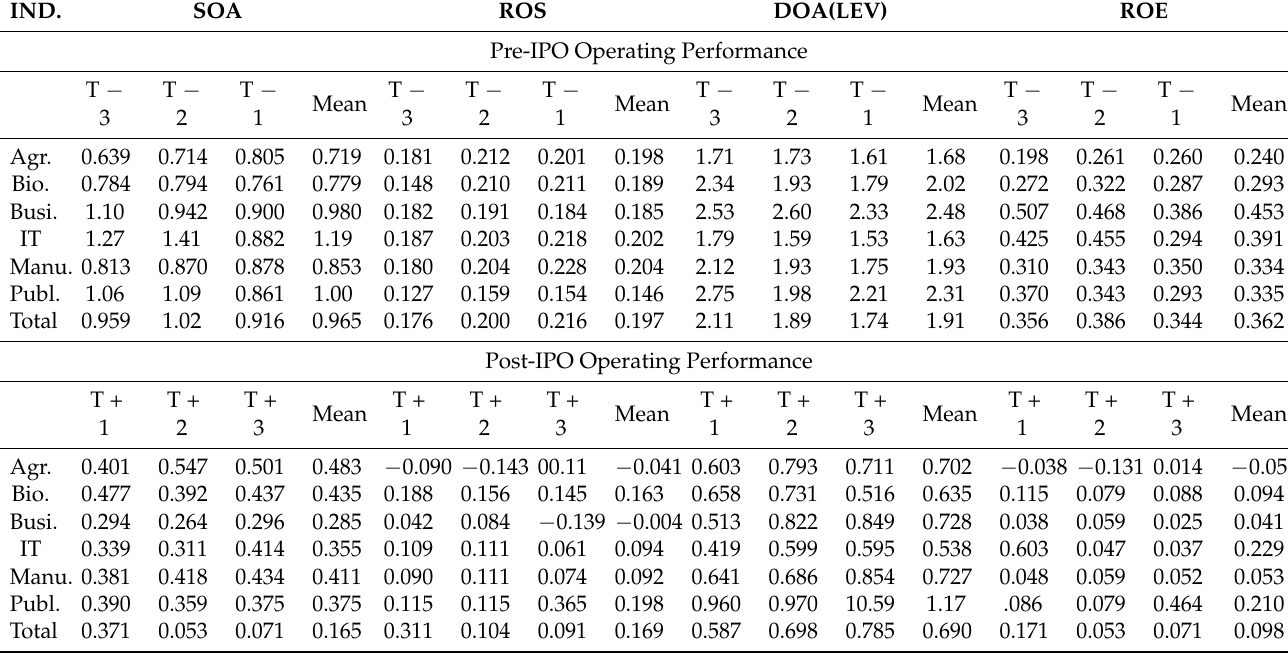
Table 5. Comparisons of operating performance between pre-IPO and post-IPO, by sector. IND. SOA ROS DOA(LEV) ROE Pre-IPO Operating Performance